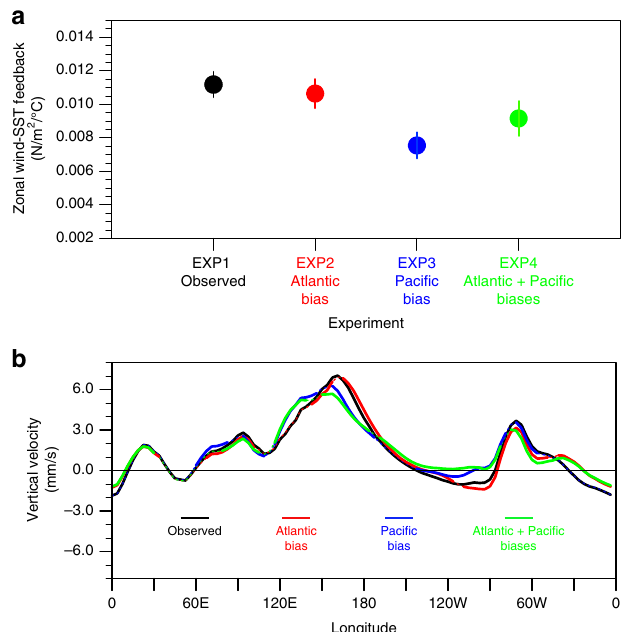
Fig. 5 Paci fi c atmospheric zonal wind-SST feedback and mean Walker circulation in coupled control simulations. a The linear regression of the monthly anomalous central Paci fi c zonal wind stress (6°S – 6°N, 160°E – 140° W) and Niño3.4 SST (5°S – 5°N, 170° – 120°W) under different SST mean state background (unit: N m − 2 °C − 1 ). Vertical bars represent the standard error of the regression coef fi cient. b Averaged equatorial (15°S – 15°N) vertical velocity (200 – 1000 hPa) in the partially coupled (PARCP) control run simulations (unit: mm s − 1 ). The solid coloured lines indicate the vertical velocity differences between the biased simulations and unbiased simulation (the black line) are statistically above the 90% con fi dence